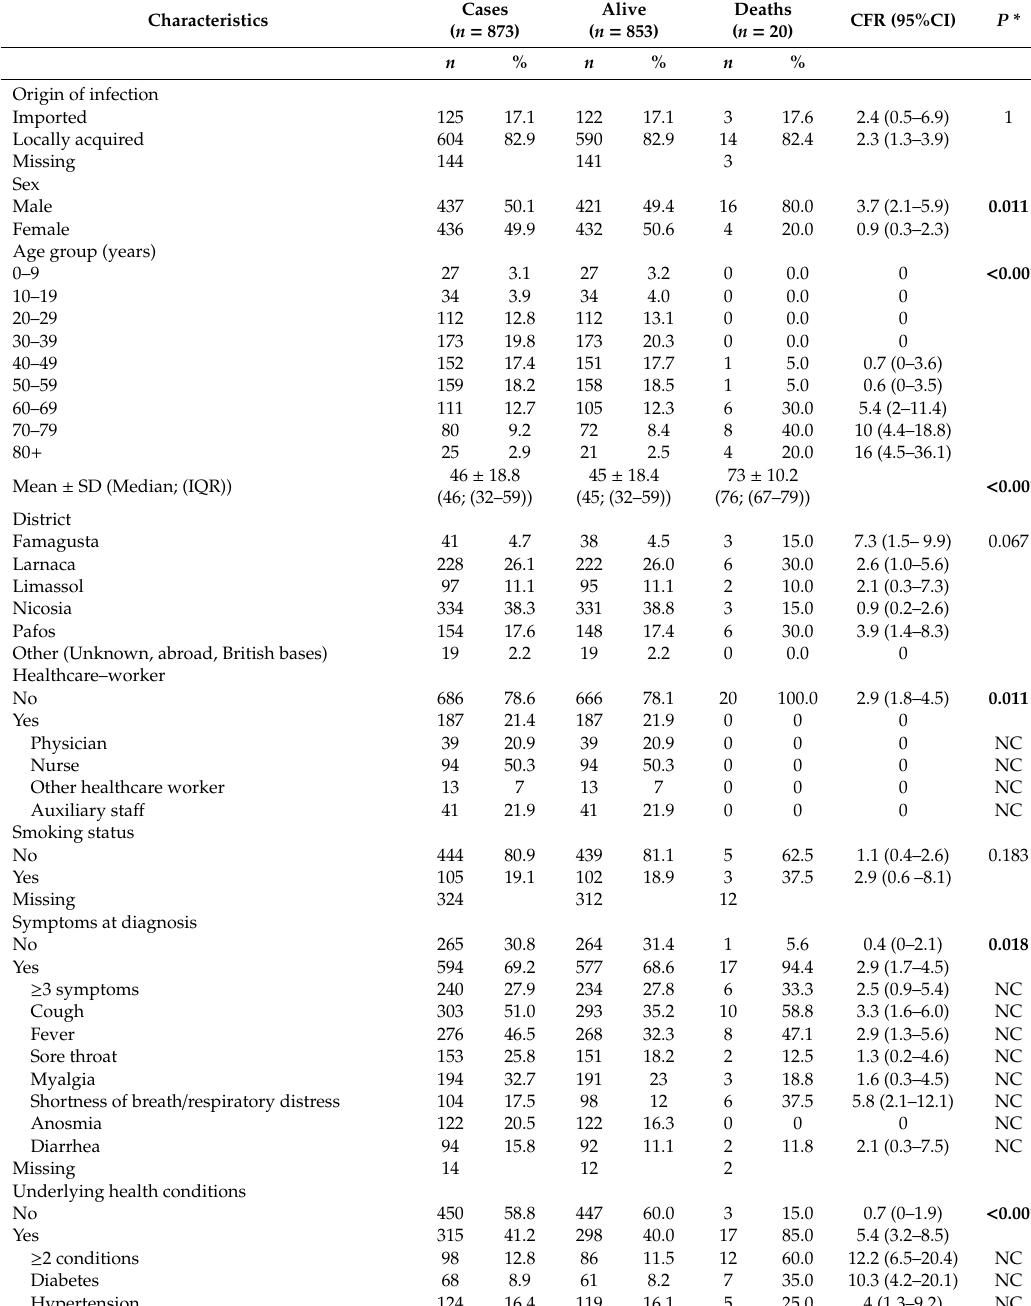
Table 1. Characteristics of laboratory-confirmed COVID-19 cases ( n = 873) and deaths among